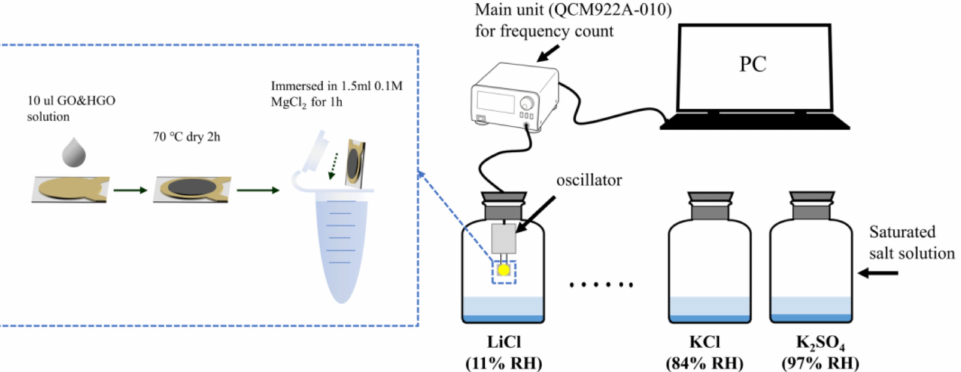
Figure 1. Schematic images of the preparation process of the HGO&GO&Mg 2+ -based quartz crystal microbalance (QCM) sensor and the humidity-sensing experimental